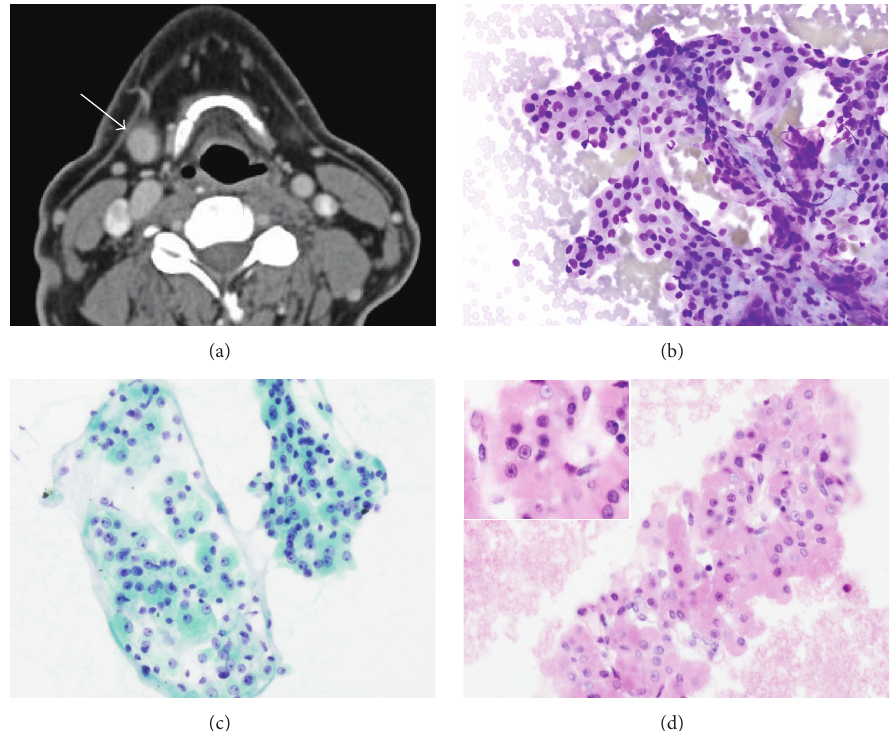
Figure 1: Imaging and cytopathology of the submandibular oncocytoma. (a) CT scan showing a well-circumscribed mass (1.6 × 1.3cm) at the right submandibular space; (b)–(d) FNA of the mass showing clusters of polygonal eosinophilic epithelial cells with low N/C ratio, round nuclei, and prominent nucleoli ((b) Diff-Quik, × 400; (c) pap smear, × 400; and (d) cell block, × 400 (inset, ×